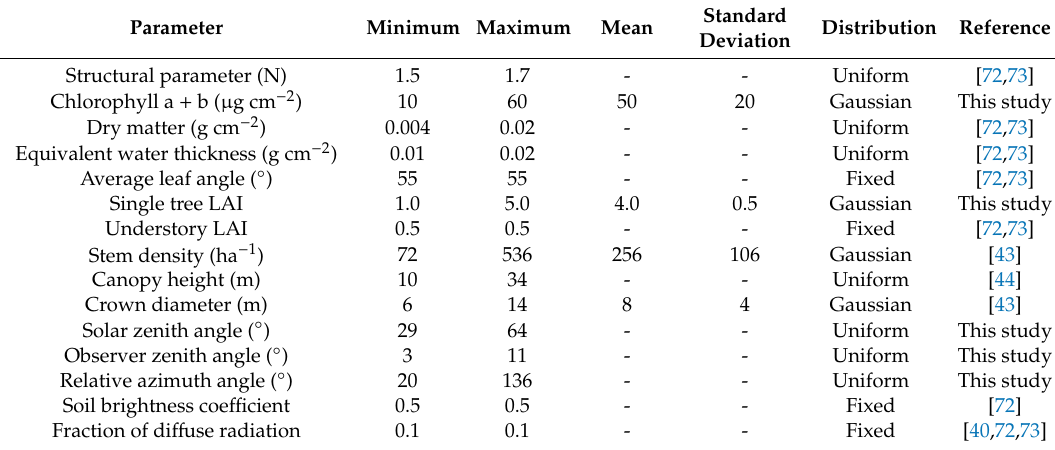
Table 2. Distributions from which Invertible Forest Reflectance Model (INFORM) input parameters were randomly